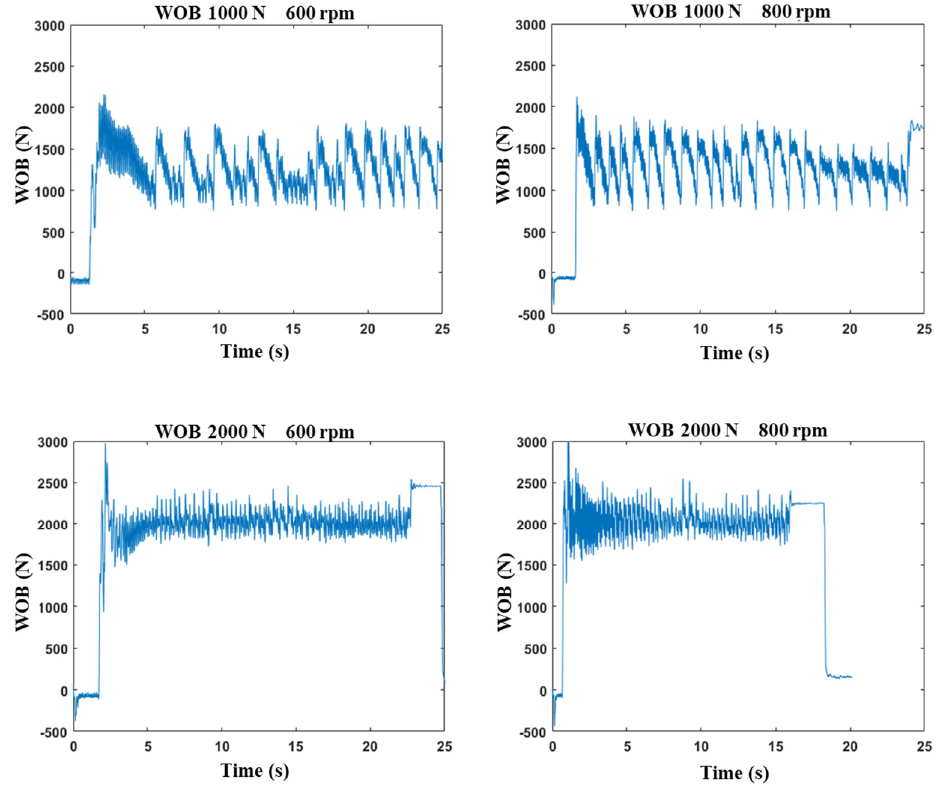
Figure 10. Test results for constant-pressure drilling mode.